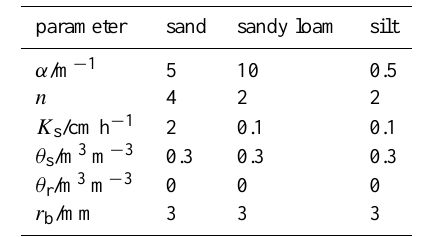
Table 1. Parameters used for the synthetic data sets: The van Genuchten parameters α and n , the saturated hydraulic conductivity K s , residual water content θ r , the saturated water content θ s , and the resistance of the boundary layer r b .